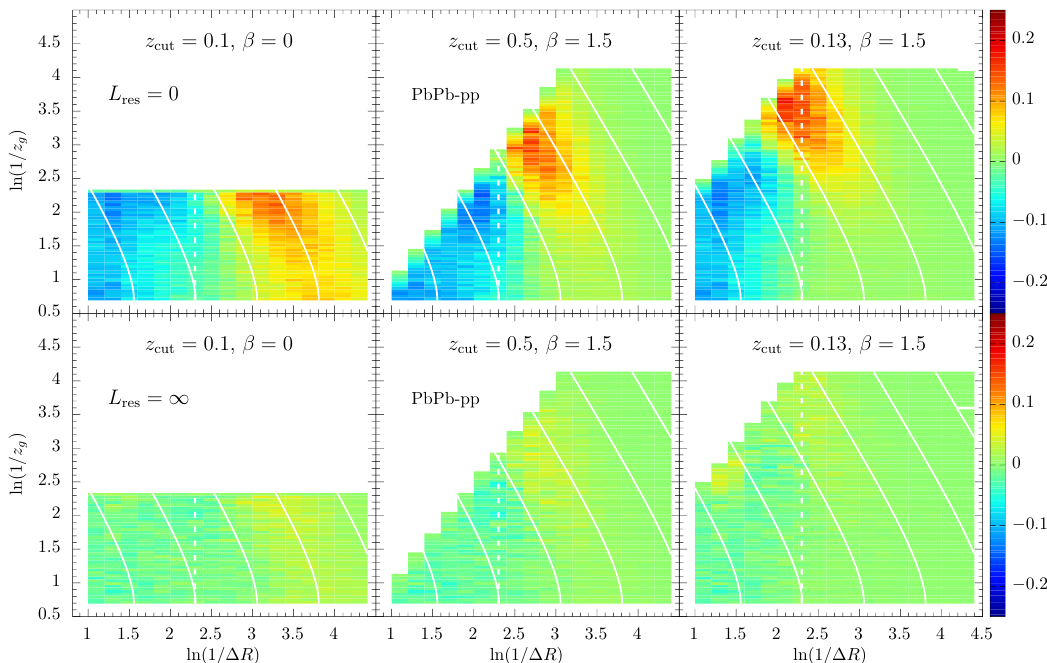
Figure 5 . Di(cid:11)erences between medium and vacuum for the (cid:12)rst Soft Drop splitting Lund planes p at s = 5 : 02 ATeV. Upper row corresponds to L res = 0 and lower row to L res = 1 . First column used the (cid:13)at grooming parameters, the middle column the core grooming parameters, and the right column the soft-core parameters; see text for details. In each case, color indicates the di(cid:11)erence between the density in the Lund plane for in-medium jets and the density in the Lund plane for vacuum jets. The individual Lund planes have been normalized to the total number of jets within the cuts, which are 140 < p jet < 300 GeV and j (cid:17) j < 1 : 3. The jets were reconstructed with anti- k t T radius R = 0 : 4. Note that the top-left panel here is, in essence, the di(cid:11)erence between the middle and left panels of (cid:12)gure 4 (not exactly, since the cuts are di(cid:11)erent) and the bottom-left panel here is, again in esssence, the di(cid:11)erence between the right and left panels of (cid:12)gure 4 White solid curves correspond to contours of constant log(1 = ( M g =p T;g )), where M g is the groomed mass and p T;g the groomed transverse momentum of the jet. The vertical dashed white line represents an angular separation of (cid:1) R = 0 :